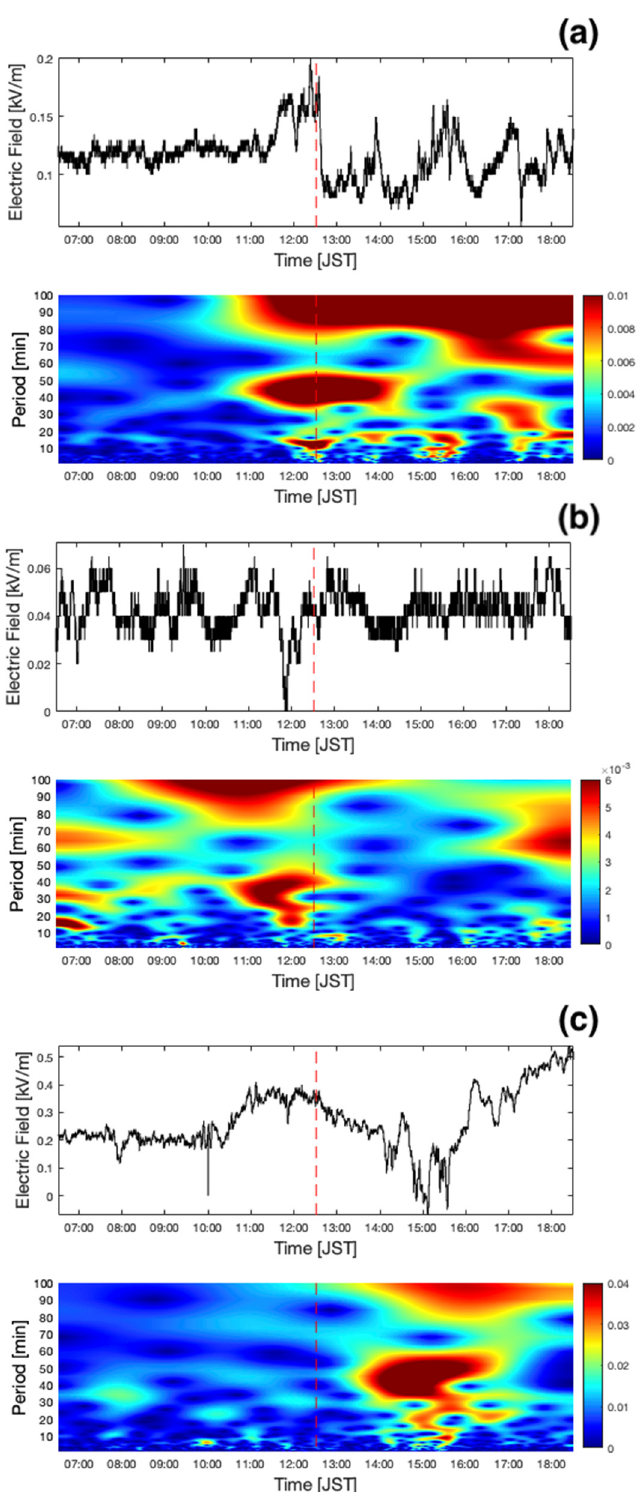
Figure 8. Time series and dynamic periodograms of the AEF with the period up to 100 min in the interval from 6 h before to 6h after EQ2: ( a ) Chofu (CHF), ( b ) Kakioka (KAK), and ( c ) Iwaki (IWK).